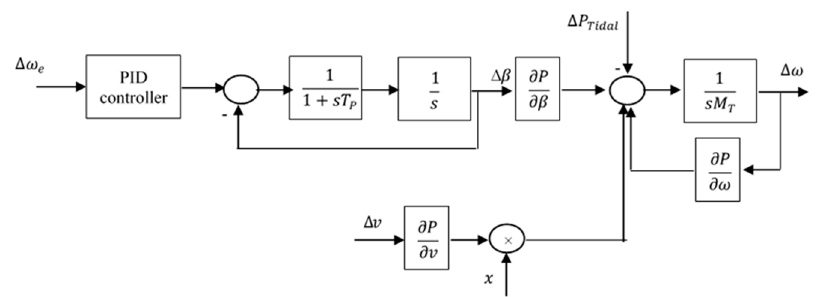
Figure 6. Blade pitch control of the tidal system.